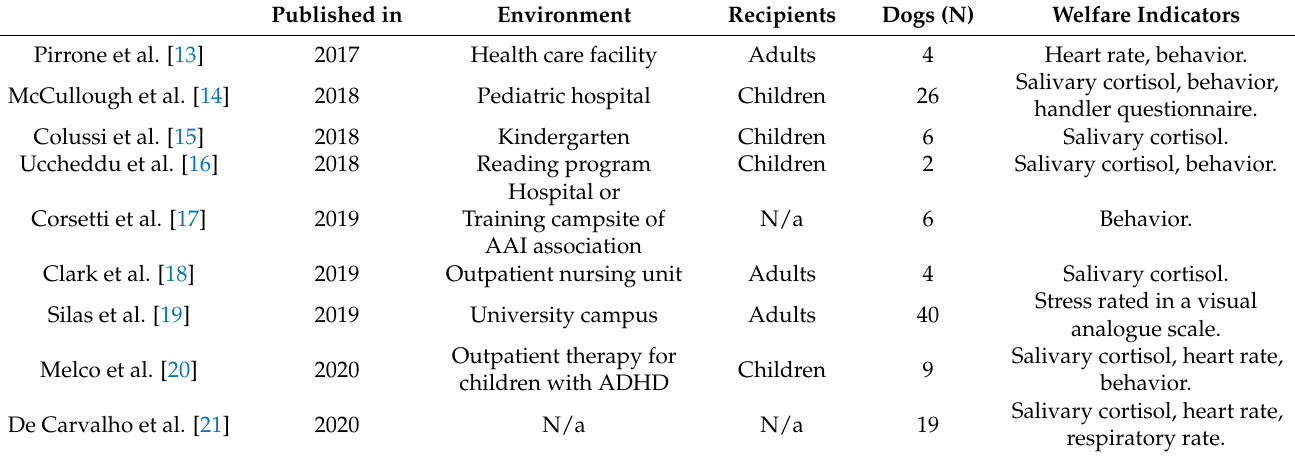
Table 1. Publication year, therapeutic environment, recipients, sample of dogs and welfare